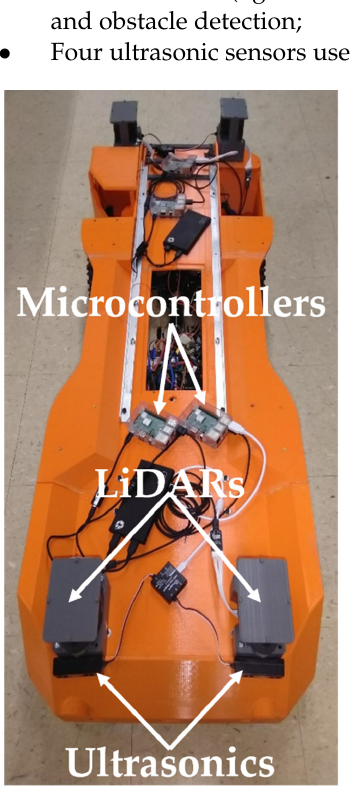
Figure 5. Prototype equipped with LiDAR and ultrasonic sensors.